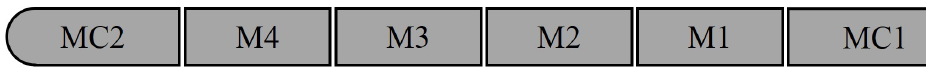
Figure 4. Schematic diagram of the maglev train with six